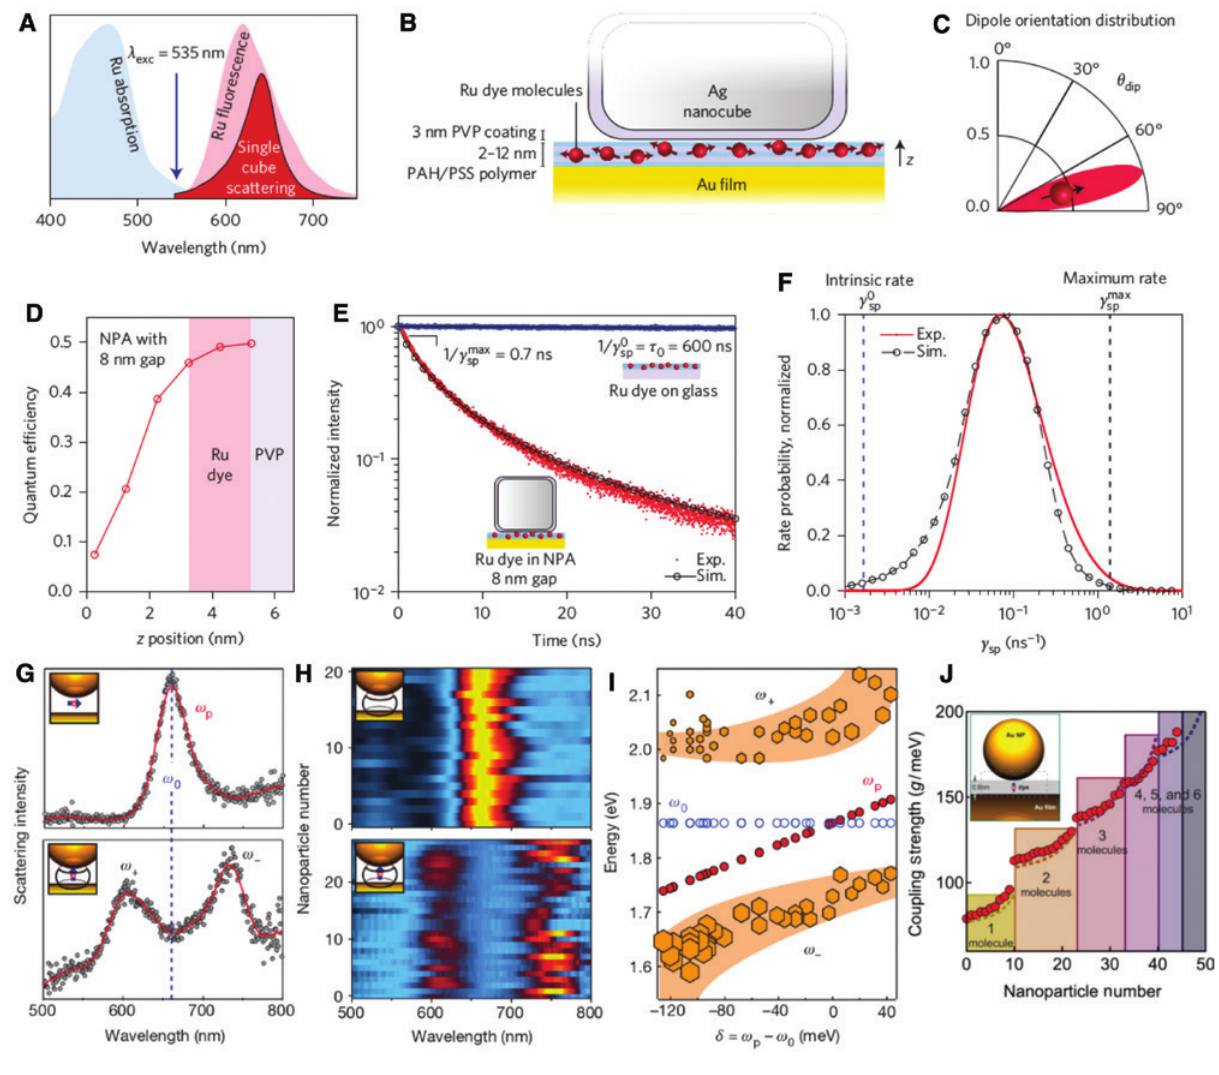
Figure 2: Strong Purcell effects and few-molecule strong coupling via plasmonic nanocavities. (Top) Experimental results [76] showing the strong enhancement of spontaneous decay by dye molecules in a nanogap between a Ag nanocube and a gold film (B). Due to the nanoscopic mode volume of the nanocube film mode, the spontaneous enhancement of dipoles inside the nanogap can be enhanced by as much as a factor of 1000 (E). Taking into account the distribution of emitters in position and orientation (C) along with the nanoparticle and molecule line shapes (A), the authors achieved good agreement between the theory of the Purcell effect and experiments (F). (Bottom) Experimental results [28] showing the strong coupling regime in the interaction of molecules with a NPoM mode with a gap of 0.9 nm (G). By measuring the scattering of light from the system of molecules + NPoM, the authors observed a strong Rabi splitting associated with the formation of coupled excitations of plasmons and molecules (H). By increasing the number of molecules to 10, the resulting collective coupling allows the strong coupling regime to be achieved (I). (A–F) Adapted with permission from Ref. [76] (© 2014 Springer Nature). (G–J) Adapted with permission from Ref. [28] (© 2016 Springer